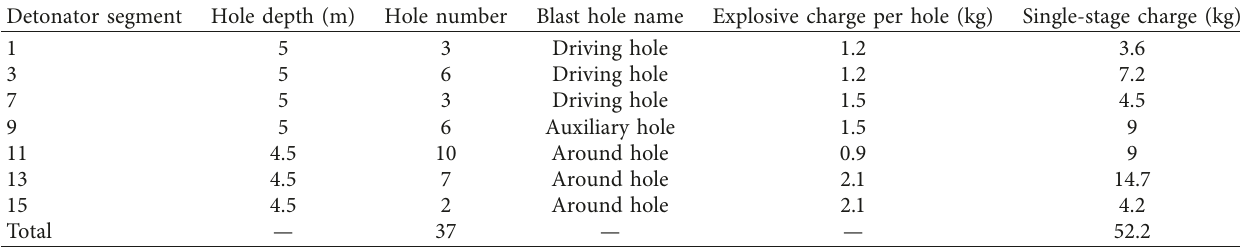
Table 2: Parameters of the lower step blasting.